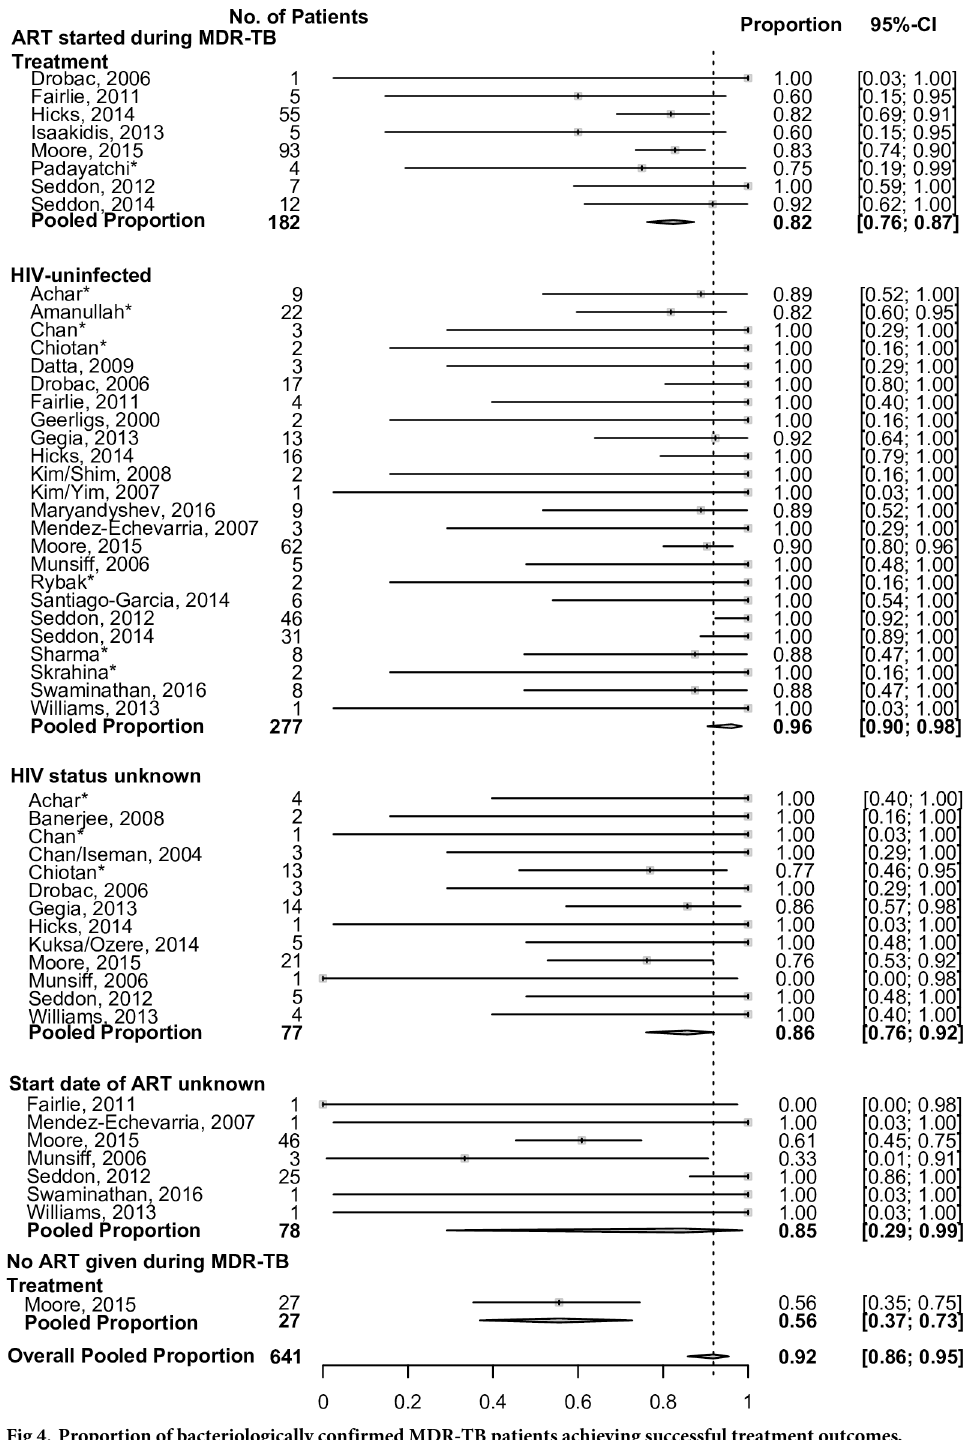
Fig 4. Proportion of bacteriologically confirmed MDR-TB patients achieving successful treatment outcomes, stratified by HIV infection and HIV ART. Data are stratified by HIV and ART status and by site. The 95% CIs were estimated using exact (Clopper-Pearson) method. Children from countries with very low HIV prevalence who did not have an HIV test were assumed not to be infected with HIV following consultation with site investigators. (cid:3) Unpublished data. ART, antiretroviral treatment; MDR-TB, multidrug-resistant tuberculosis.